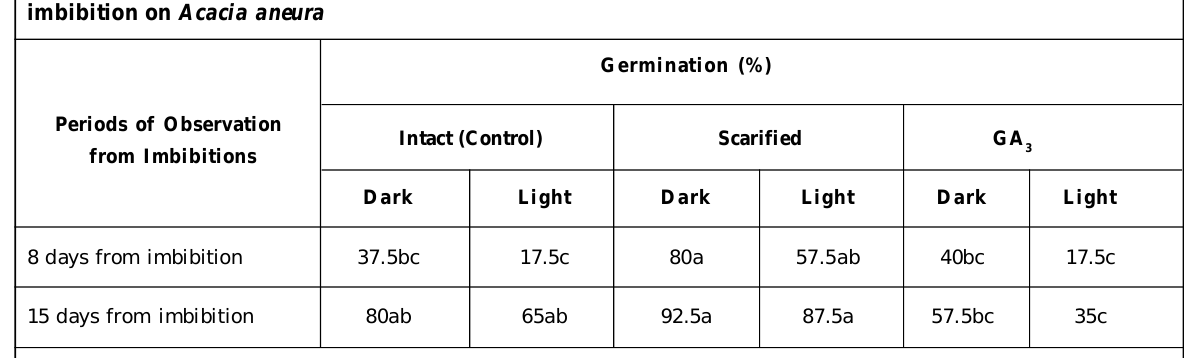
and light/dark on percentage germination at 8 days and 15 days from 3